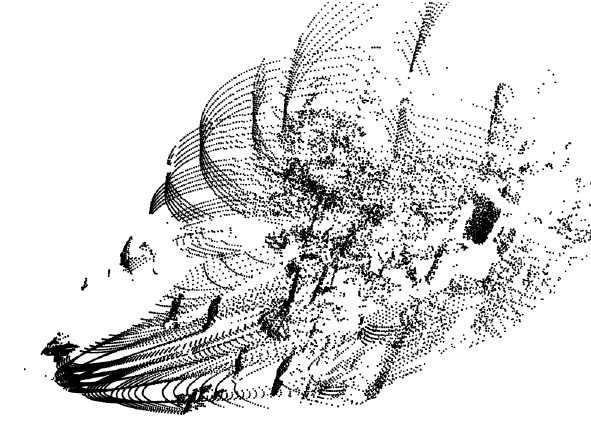
Figure 1. Point cloud recording from the Courtyard dataset, recorded using the Livox Avia sensor with its Non-repetitive Circular Scanning (NRCS) technique number of the laser beams, while the horizontal resolution de- pends on the speed of the sensor rotation. Each laser point of the output point cloud is associated with 3D spatial coordinates, and possibly with auxiliary channels such as reflection number or an intensity value of laser reflection. RMB Lidars can pro- duce high frame-rate point cloud videos enabling dynamic event analysis in the 3D space. On the other hand, the measurements have low spatial density, which quickly decreases as a function of the distance from the sensor, and the point clouds may exhibit particular ring patterns typical of the sensor